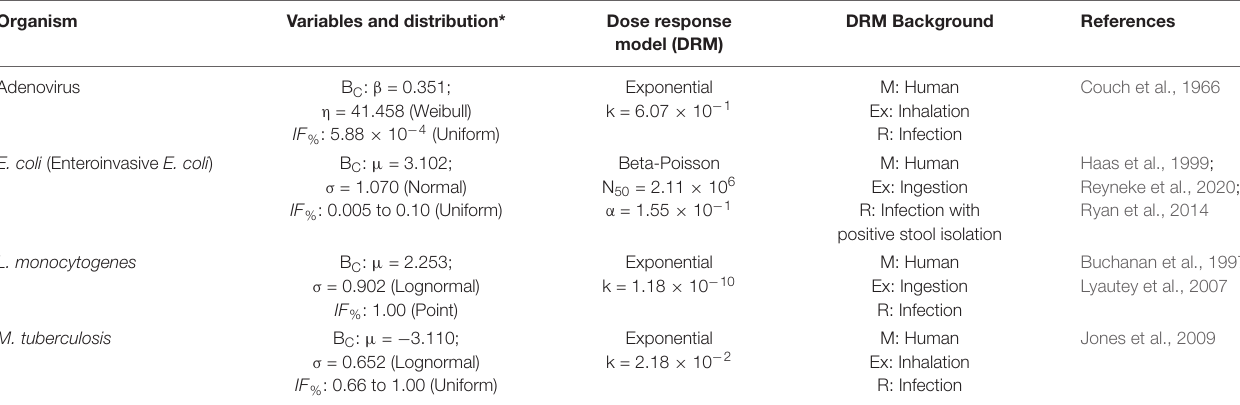
TABLE 2 | Monte Carlo simulation dose response input parameters for the target pathogens.